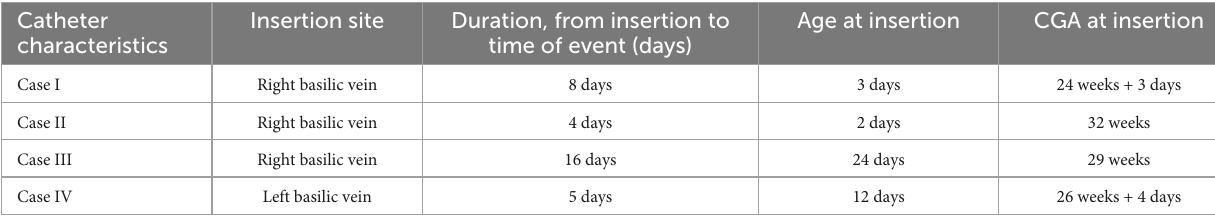
TABLE 1 Characteristics of neonates.